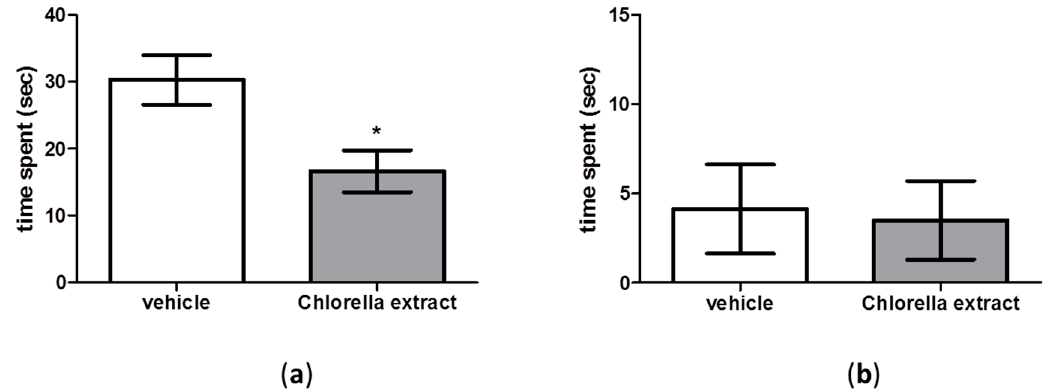
Figure 5. The social interaction test in male Wistar rats after Chlorella sorokiniana extract or vehicle administration. ( a ) Time spent performing social and ( b ) time spent performing aggressive behaviour. Male Wistar rats were treated with Chlorella sorokiniana extract (Chlorella extract, 30 mg/kg/mL dark bar) or vehicle (sunflower oil 1 mL/kg, empty bar) administration. Data are expressed as mean ± SEM ( n = 8 per group); ( a ) t -test * p < 0.05 vs. vehicle-treated rats.